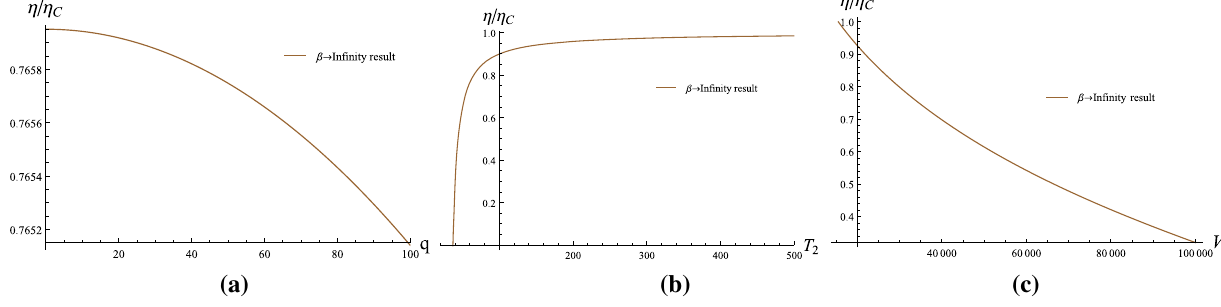
Fig. 7 Effect of parameters on efficiency, when other parameters (see the caption of Fig. 2 for parameter values) are fixed and α = 0 .